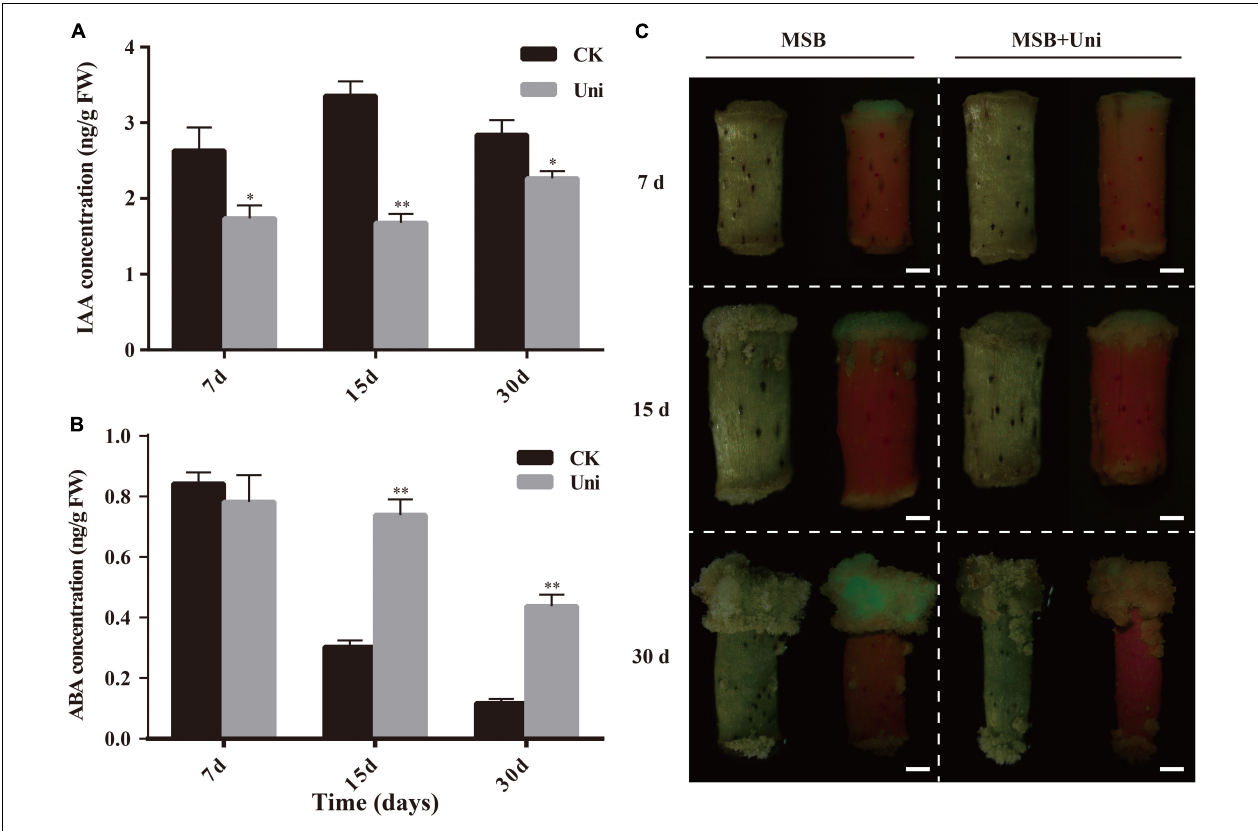
FIGURE 3 | Effects of exogenous uniconazole on the plant hormone levels at different stages of callus in ZM24. (A) DR5-GFP expression in calli of ZM24 transformed plants at 7 days (d), 15- and 30-day induction on Murashige and Skoog Basal (MSB) medium or MSB medium-plus uniconazole (Uni), scale bar = 1 mm. (B) Indole acetic acid (IAA) concentration in callus during induction and proliferation stages at 7, 15, and 30 days of cultivation under CK or uniconazole (Uni). (C) Abscisic acid (ABA) concentrations at callus induction and proliferation stage. The single asterisk indicates statistical significance at p < 0.05. The double asterisk indicates statistical significance at p <